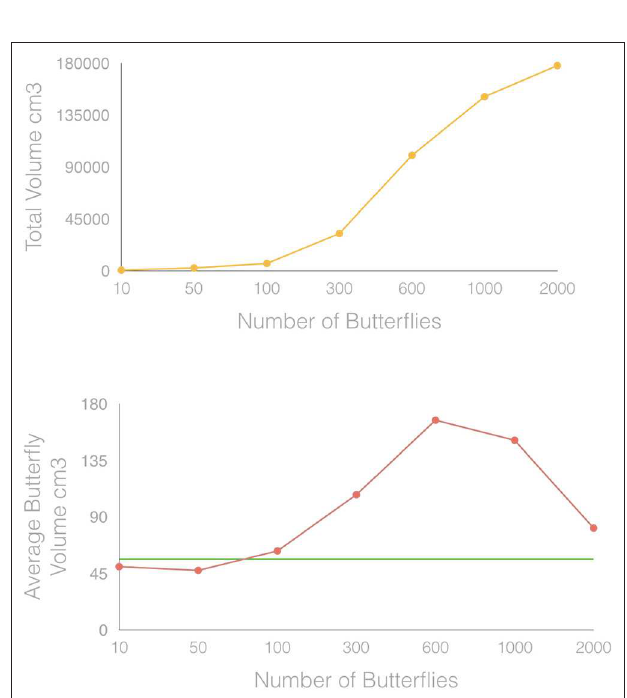
FIGURE 8 | Results for total cluster volume and individual butterfly volume derived from virtual simulation of butterfly clusters of different size. Predictably, the total volume of the clusters increased with increased number of butterflies. However, the calculated average volume of an individual butterfly in each of these clusters (red line), deviated from the empirically measured value (green